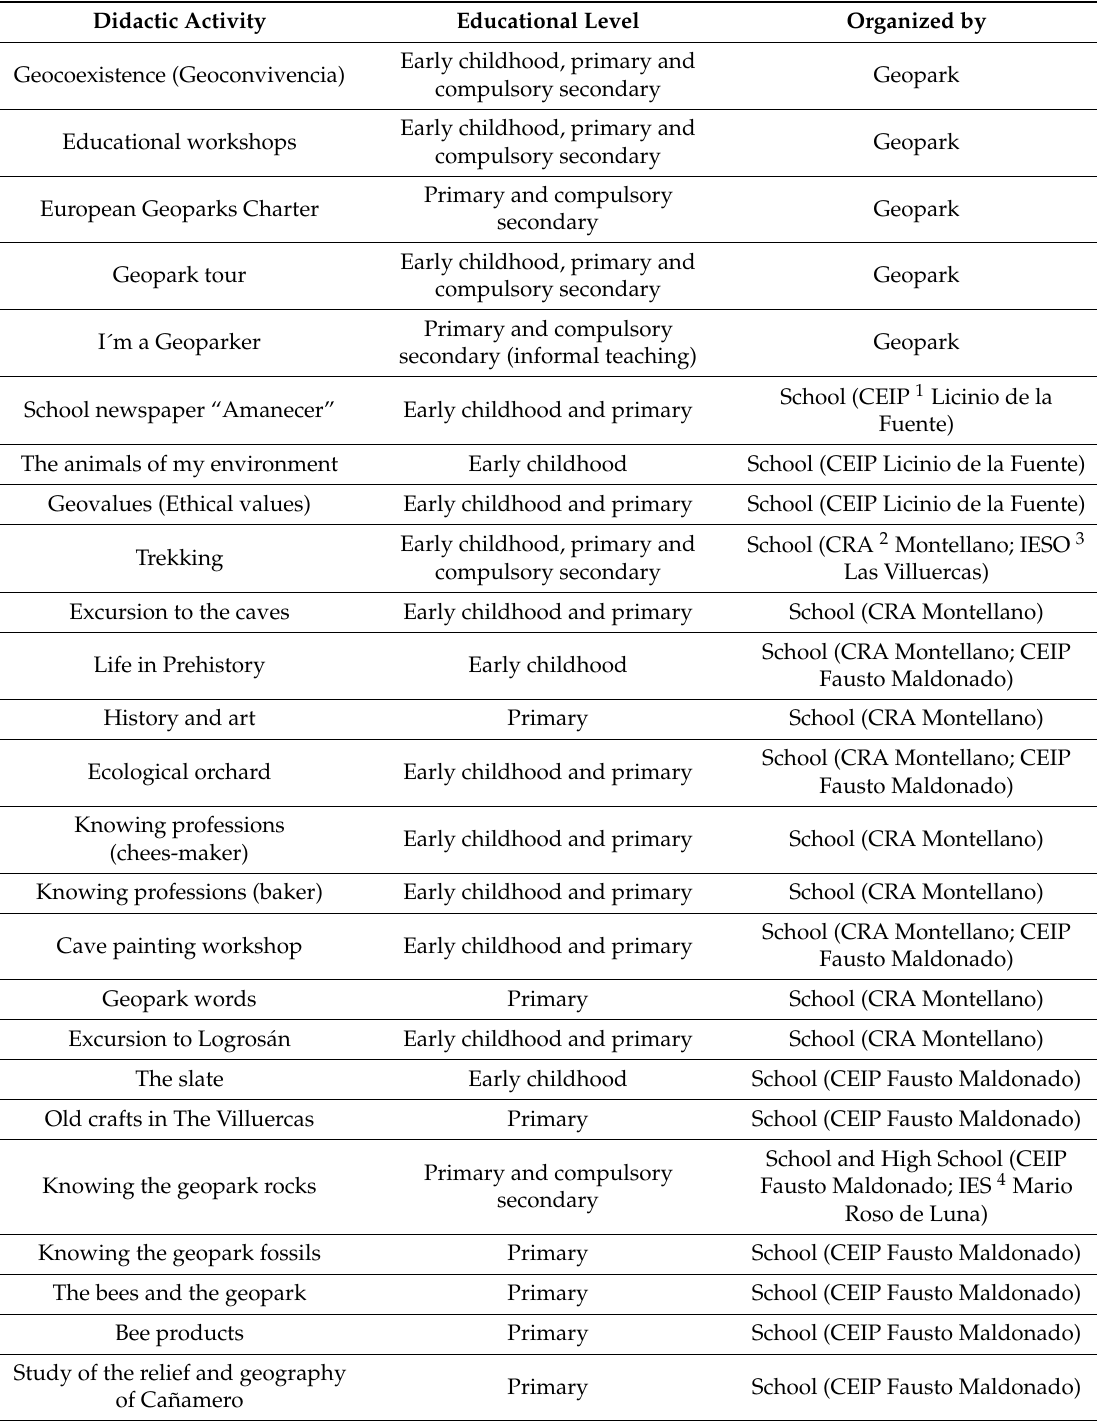
Table 4. Teaching activities held at the schools located in the geopark. Source: UNESCO Global Geopark Villuercas-Ibores-Jara and Geopark Text-book.